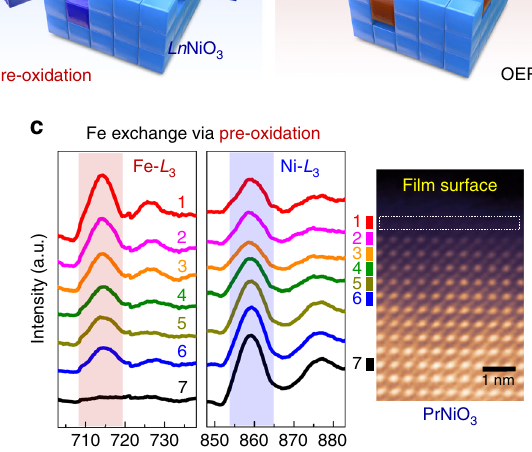
densities for the samples with the surface Fe exchange. In parti- cular, as is apparent in the speci fi c comparison in the bar graph in the right-hand column, the OER catalytic activity of the